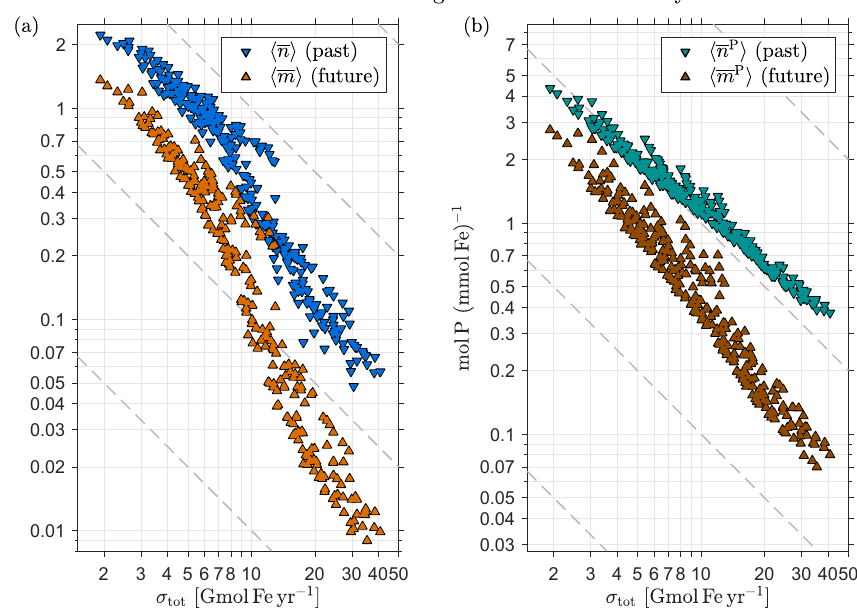
Figure 7. (a) The globally averaged mean number of past and future DFe passages through the biological pump per injected DFe molecule (regardless of source type), (cid:104) n (cid:105) and (cid:104) m (cid:105) , as a function of the total iron source strength, σ tot , for the family of state estimates of Pasquier and Holzer (2017). (b) The corresponding globally averaged mean number of phosphorus molecules exported per DFe molecule, (cid:104) n P (cid:105) and (cid:104) m P (cid:105) . Note the log–log axes to highlight the approximate inverse relationship with σ tot . To guide the eye, dashed grey lines indicate an exact σ − 1 tot power